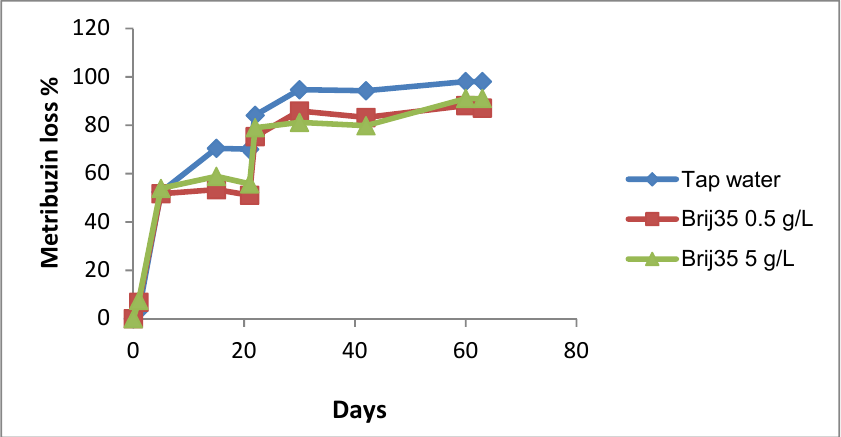
Figure 3. Metribuzin lost percentage in the season in the absence and presence of